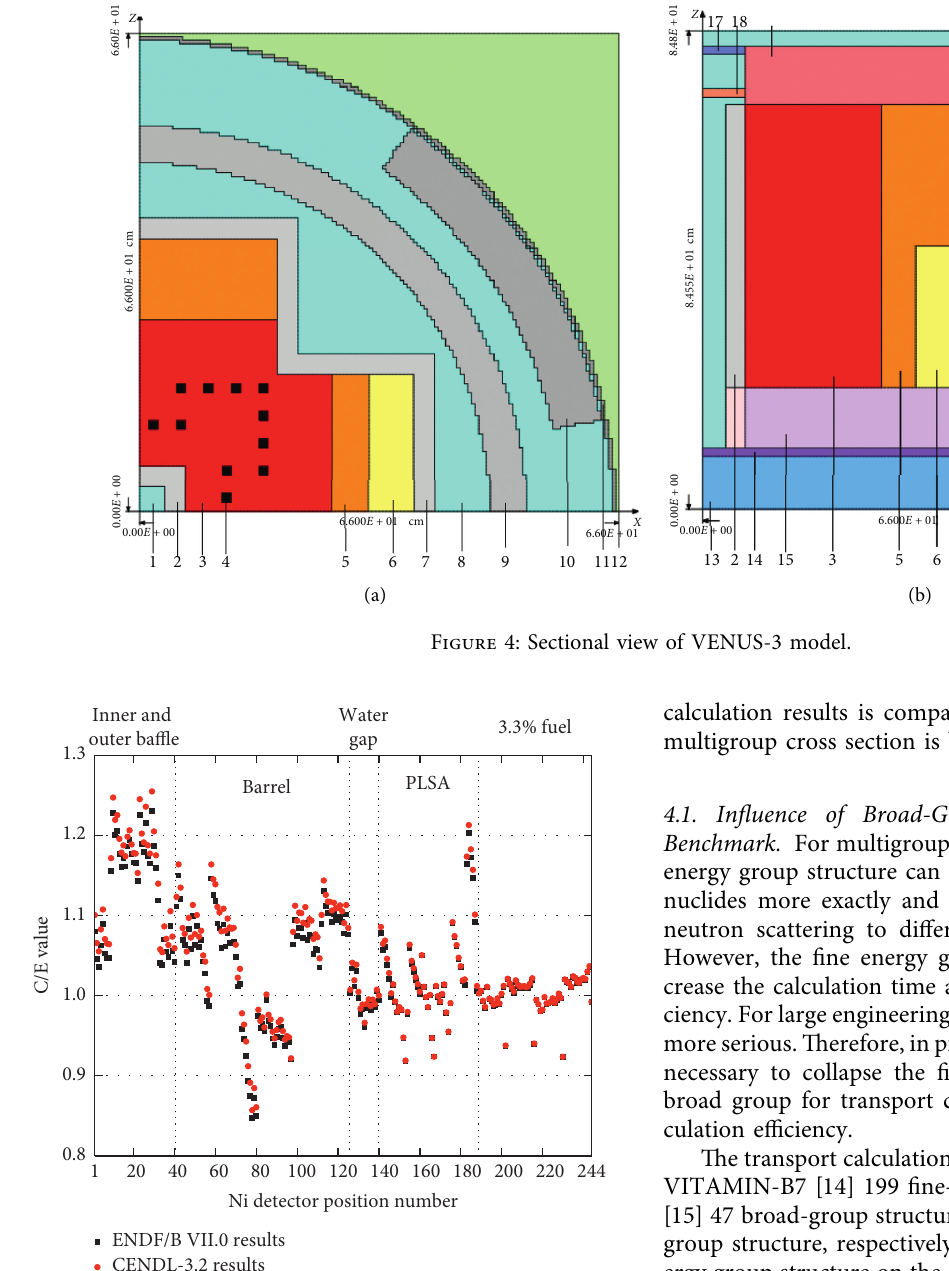
Figure 5: Equivalent fission flux ratios (calculated/experimental) of the 58 Ni(n,p) 58 Co detector.